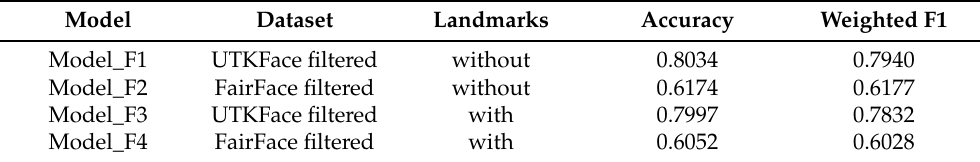
Table 18. Comparison of testing results on UTKFace filtered and FairFace filtered dataset. Model